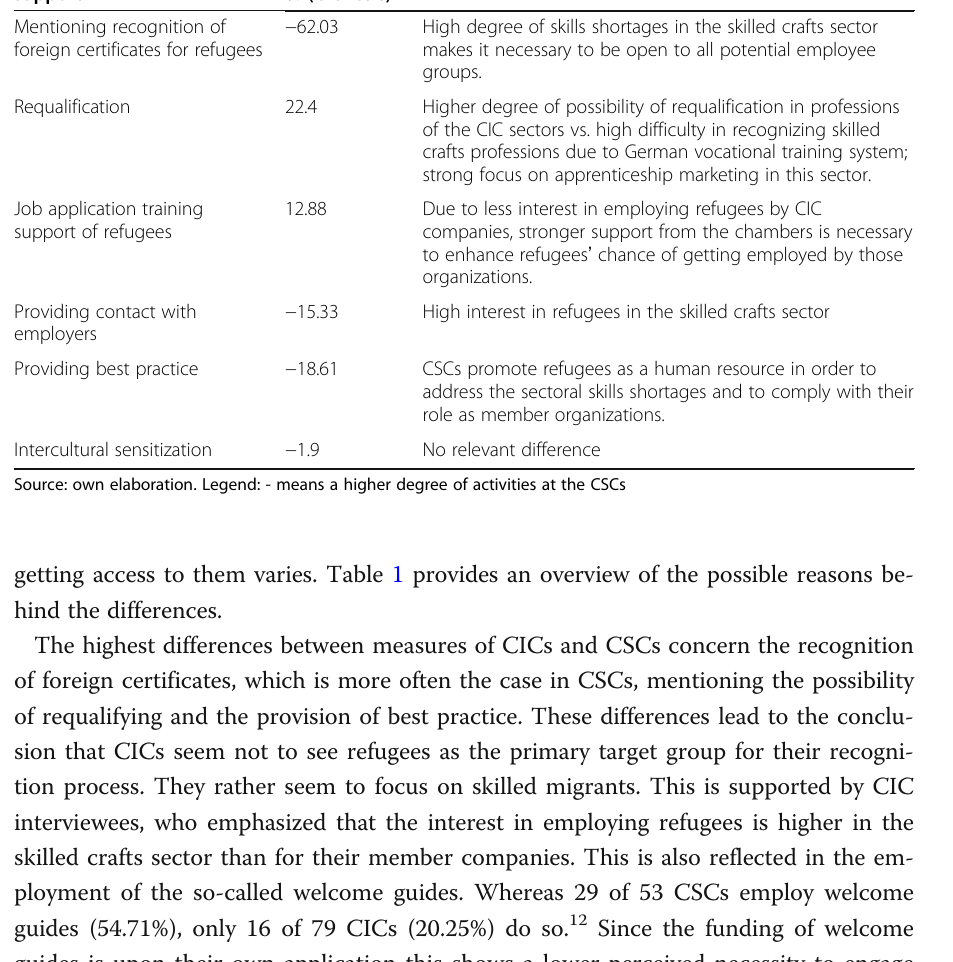
Difference in Possible % (CIC – CSC)